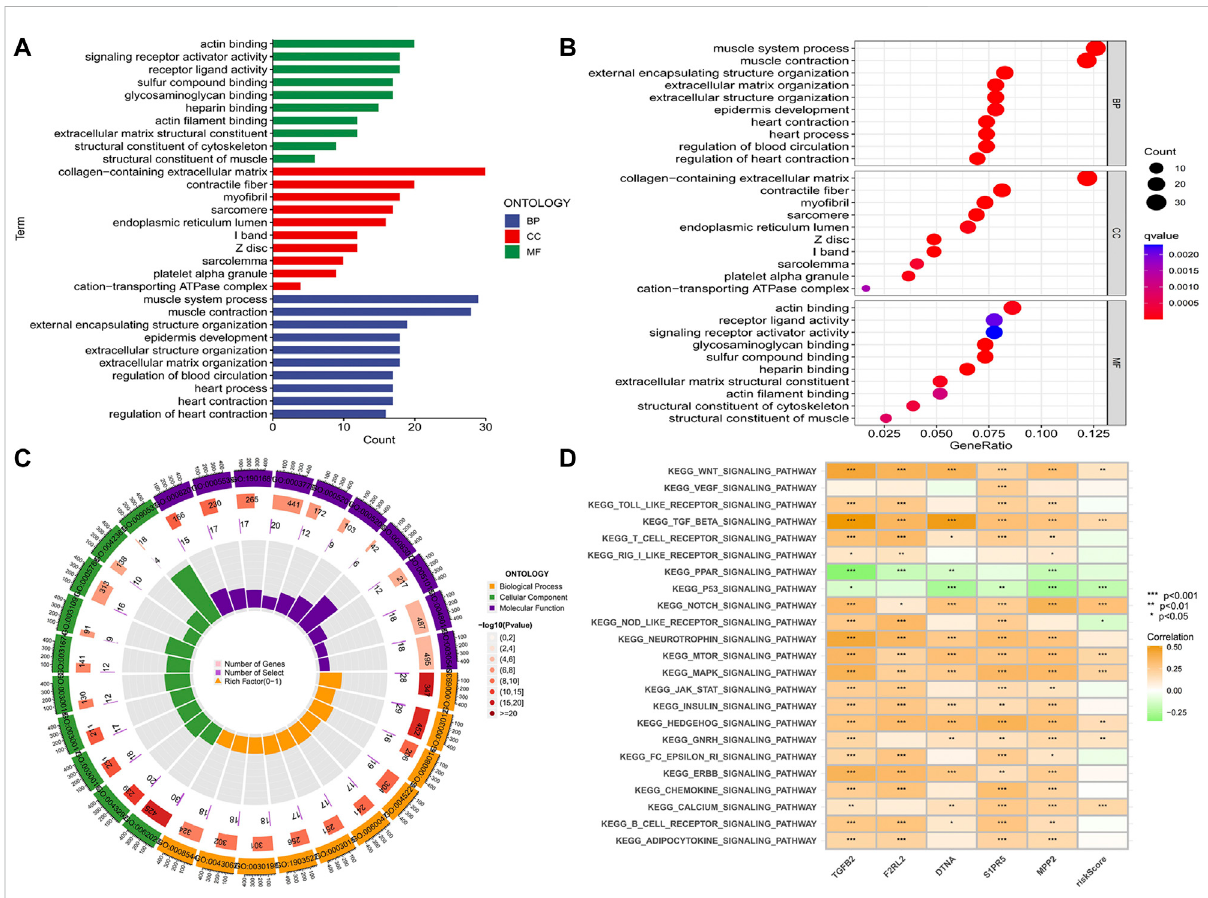
FIGURE 10 Functional andpathway enrichmentanalysis. (A-C) Histogram,bubble plot,andcircleplotofGOenrichmentanalysisshowed 30functions that were signi fi cantly associated with differential risk genes and the number of genes enriched on each function. (D) Correlation of fi ve hub genes and risk score with the KEGG pathway (* p < 0.05, ** p < 0.01,*** p <